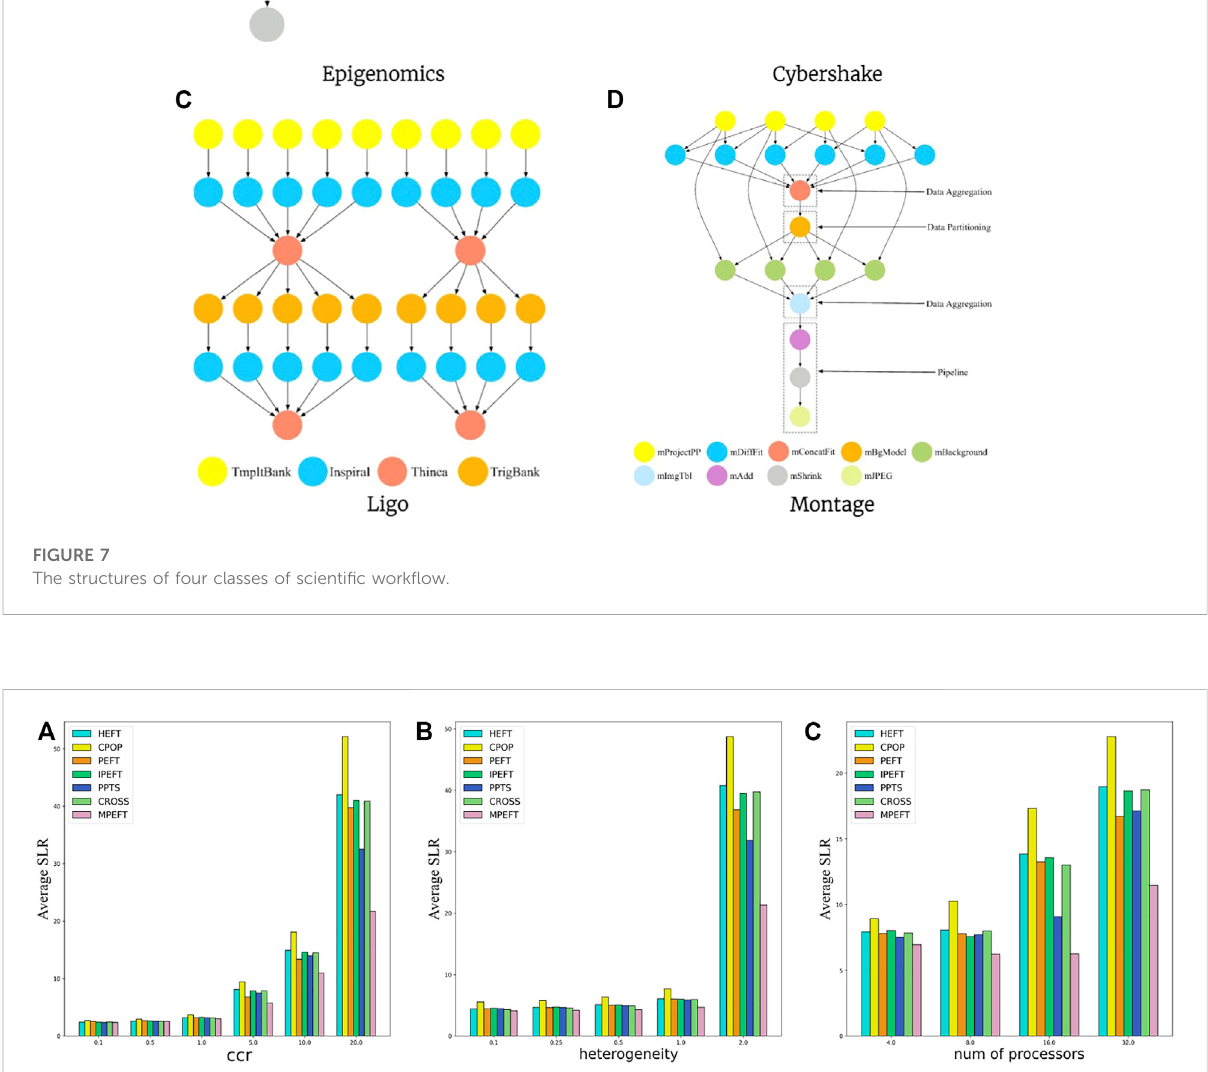
Frontiers in Environmental